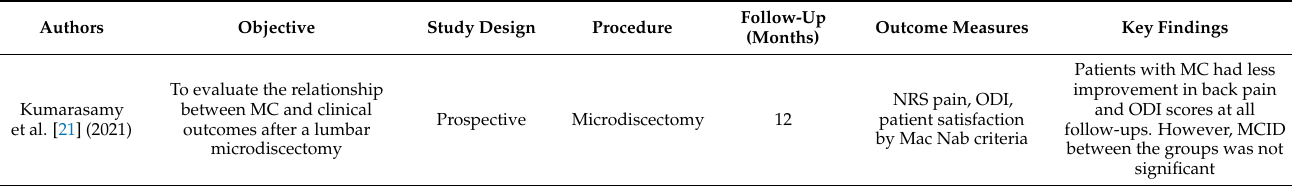
Table 4. The key findings of surgery in patients with lumbar Modic changes.